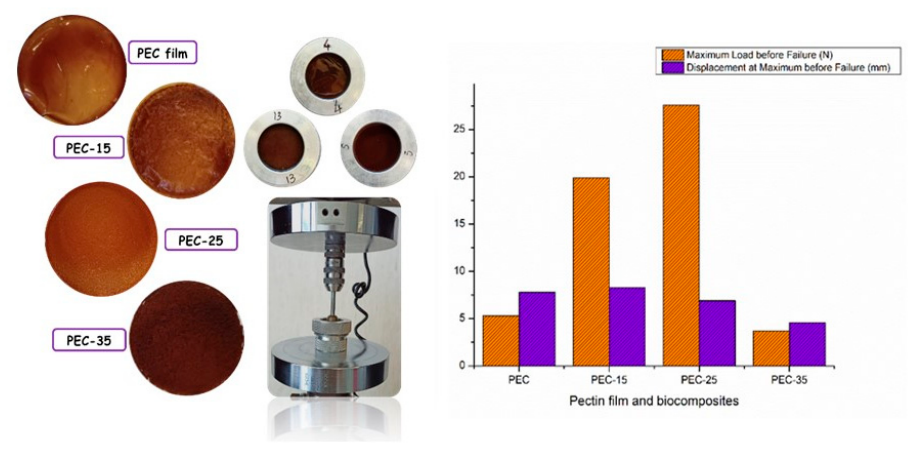
Figure 5. Puncture tests of the pectin film and biocomposites.